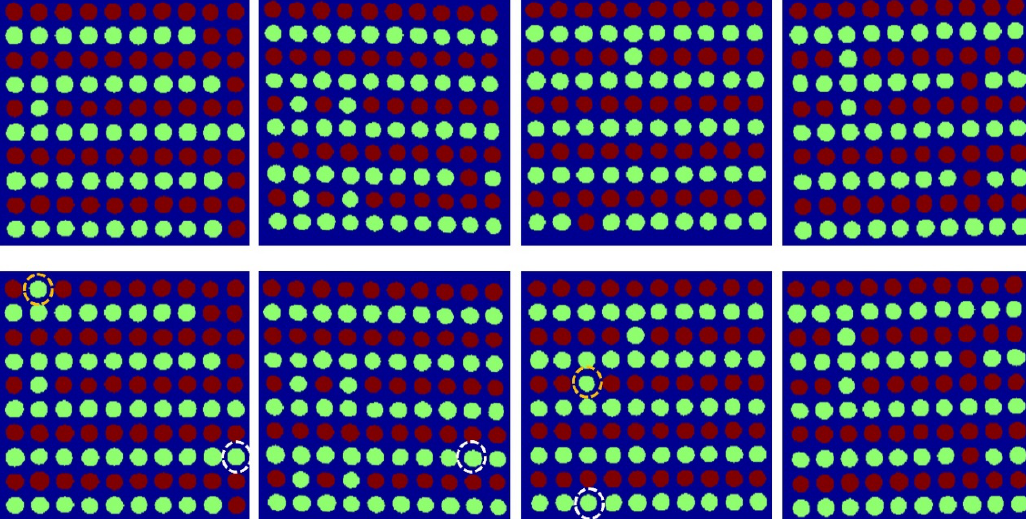
Figure 7. The resultant images by VIP PLS-DA model from raw data in the first row with 50% detection rate and in the second row with optimum detection rate. (Viable: red; non-viable: green.)